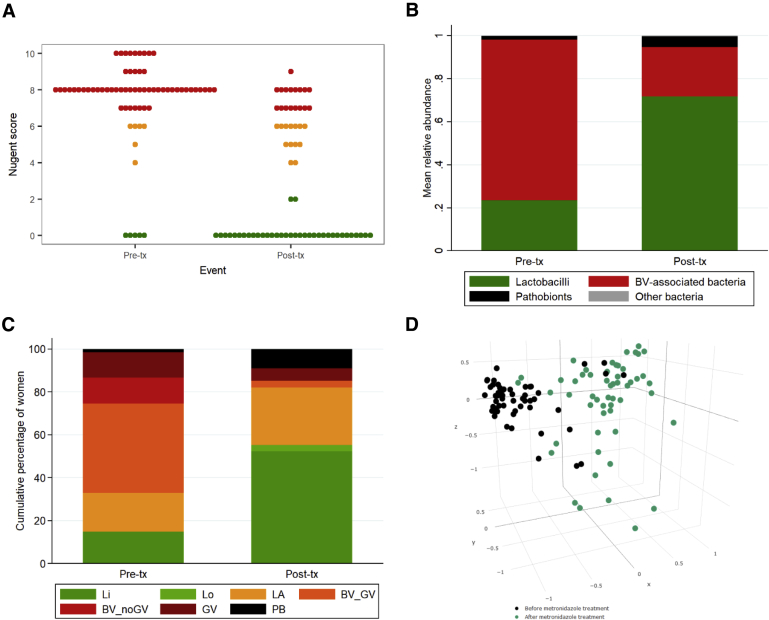
Nugent scores, mean bacterial group relative abundances, and vaginal microbiota types pre- and posttreatmentA–C, Changes in vaginal microbiota characteristics before and after metronidazole treatment. A, Nugent scores, B, mean bacterial group relative abundances, and C, vaginal microbiota types. D, Three-dimensional non-metric multidimensional scaling plot based on rarefied relative abundances of samples before and after metronidazole treatment. The figure shows that samples cluster together by visit (and hence, treatment status).BV, bacterial vaginosis; BV_GV, polybacterial Gardnerella vaginalis-containing; BV_noGV, polybacterial but low G. vaginalis; GV, G. vaginalis-dominated; IQR, interquartile range; LA, lactobacilli and anaerobes; Li, Lactobacillus iners-dominated; Lo, other lactobacilli-dominated; PB, pathobionts-containing; Post-tx, posttreatment visit; Pre-tx, pretreatment visit.Verwijs et al. Impact of oral metronidazole treatment on the vaginal microbiota and correlates of treatment failure. Am J Obstet Gynecol 2020.